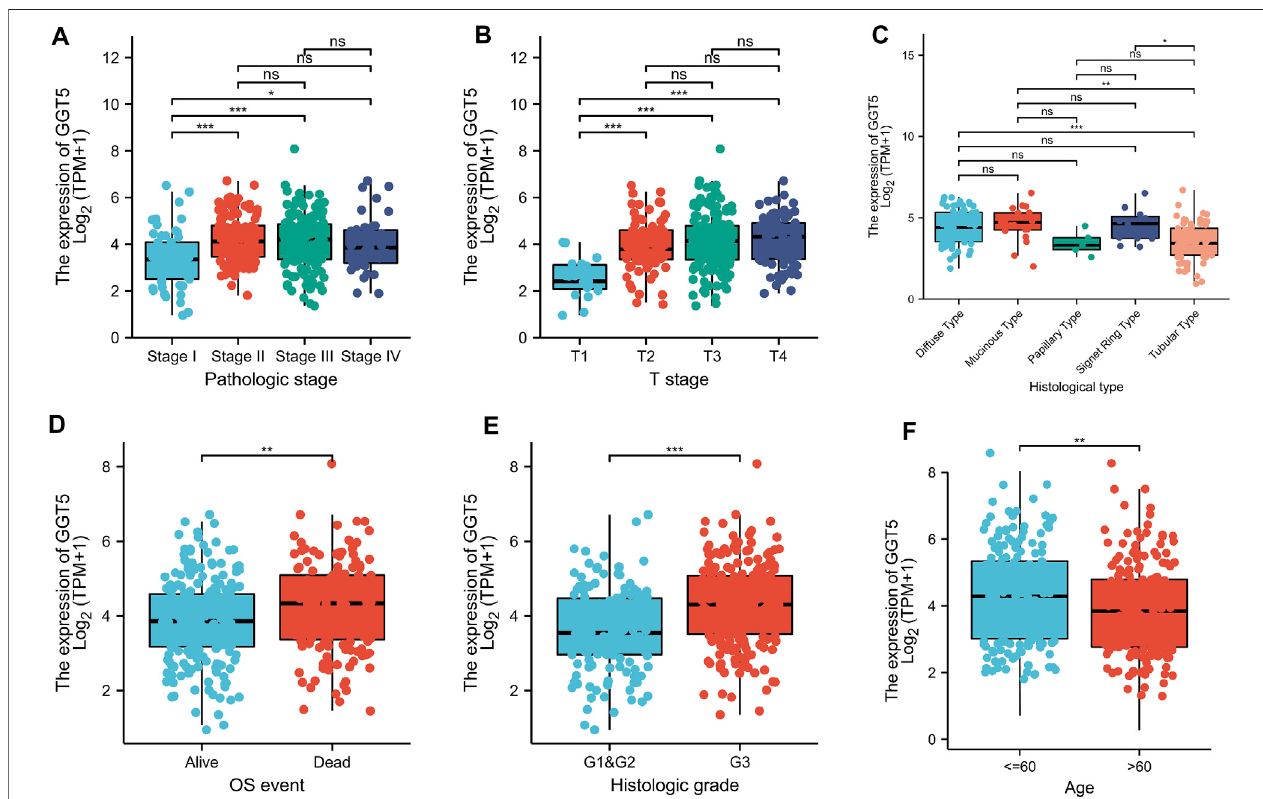
FIGURE 2 | Correlation between GGT5 expression level and the clinicopathological features of gastric cancer patients for (A) pathologic stage, (B) T stage, (C) histological type, (D) OS event, (E) histologic grade, and (F) age. *, p < 0.05; **, p < 0.01; ***, p < 0.001; ns, not signi fi cant, p > 0.05.